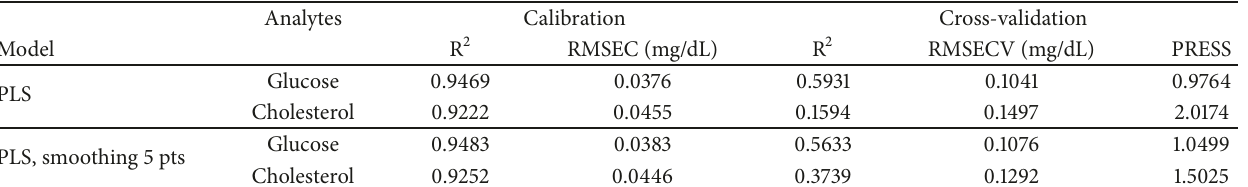
Table 1: Parameters of PLS model (400-600 nm, 5 nm interval).